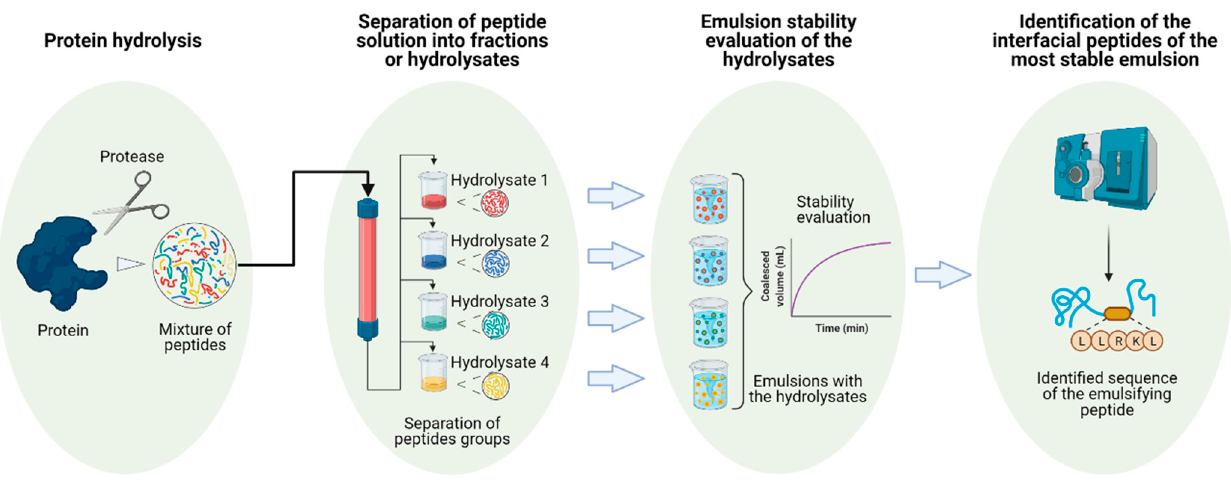
Figure 5. Schematic process for the discovery of emulsifying peptides from proteins. The protein is cut into peptides by a protease. Then, the mixture of peptides is separated by chromatography and different fractions are generated according to their hydrophobicities. Each fraction is then used to produce emulsions whose stability is evaluated. Finally, the most representative peptide contained in the emulsion with the highest stability is identified by proteomics methods (created with BioRender®, San Francisco, CA, USA).